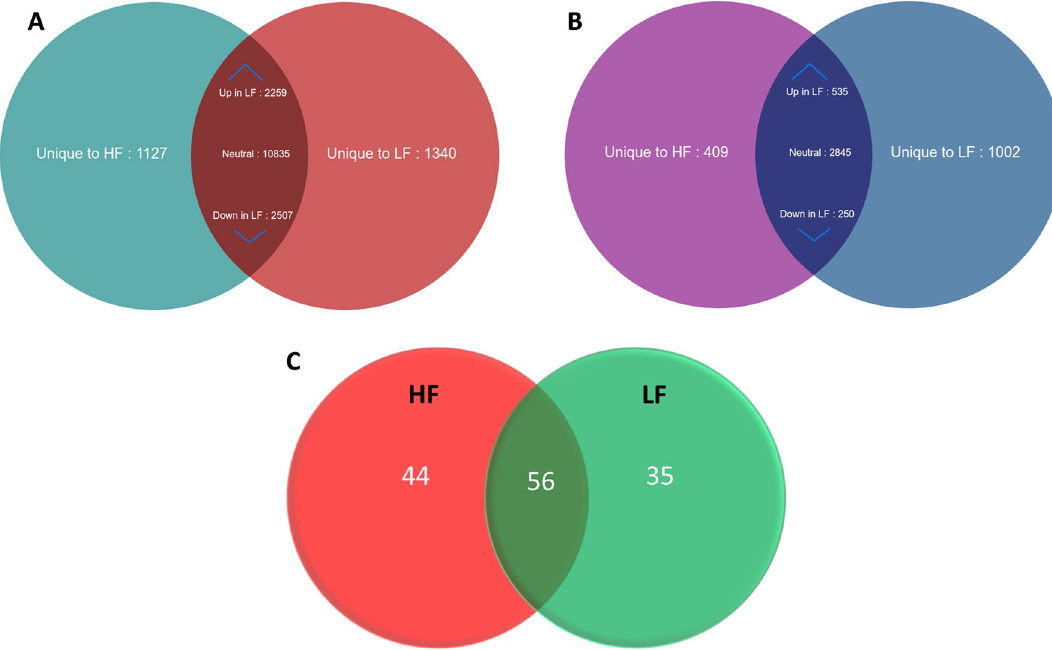
Figure 1. Venn diagram representing total number of transcripts ( A ), proteins ( B ) and metabolites ( C ) detected in high- and low-fertility bull spermatozoa. HF high-fertility, LF low-fertility bulls. The number of upregulated (Up) and downregulated (Down) transcripts and proteins are also indicated in the